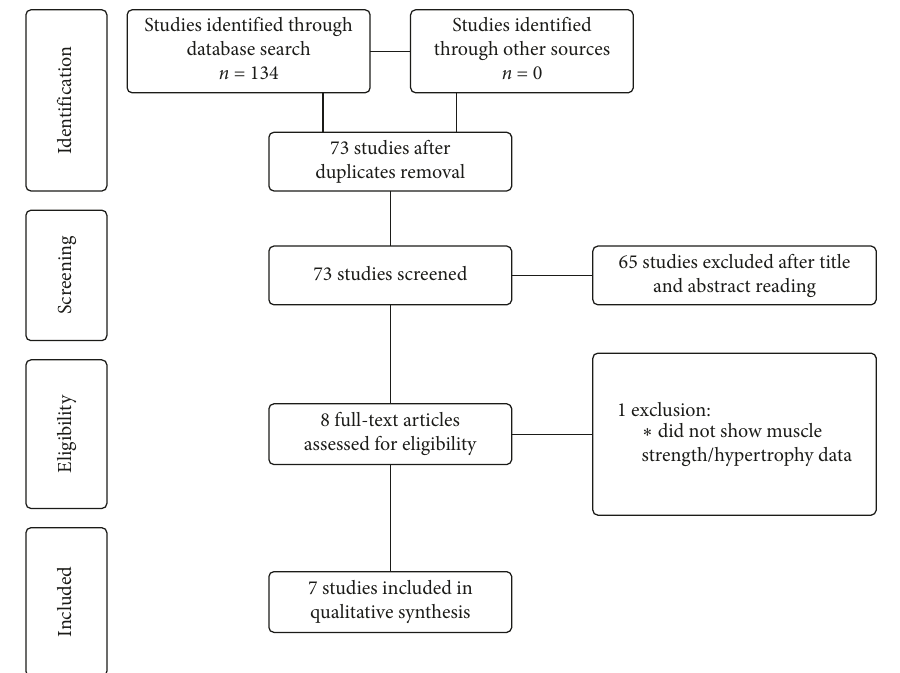
Figure 1: Flowchart of the study.